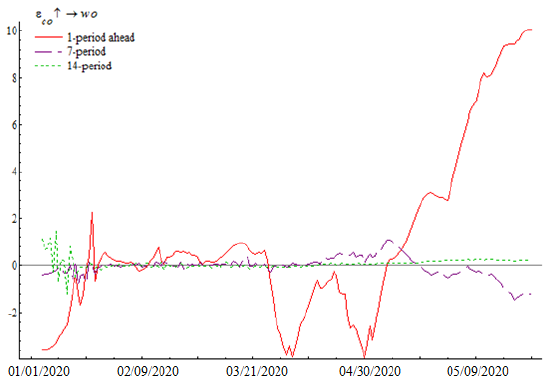
Figure 4. Impulse responses for the set COVID-19 and log prices. Note: The abscissa refers to the date in the first half of 2020, and the ordinate indicates the impulse response values after the shock of one-unit standard deviation.